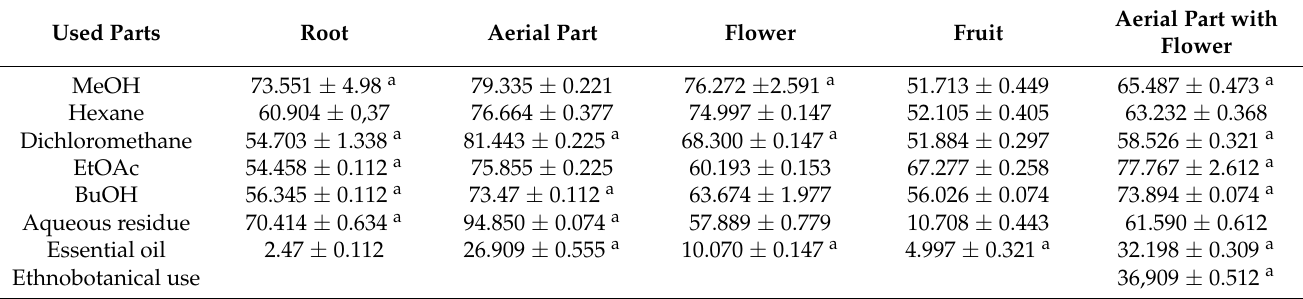
Table 4. Total phenolic contents of the extracts, sub-extracts, essential oils, and ethnobotanical use from Hypericum scabrum (mg/g) ± SD a